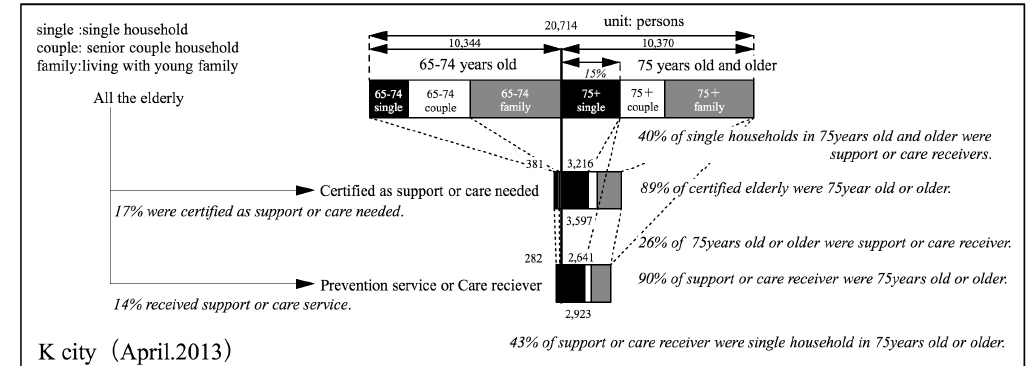
Figure 4. Total number of elderly, certified, and receivers of care services in K city.